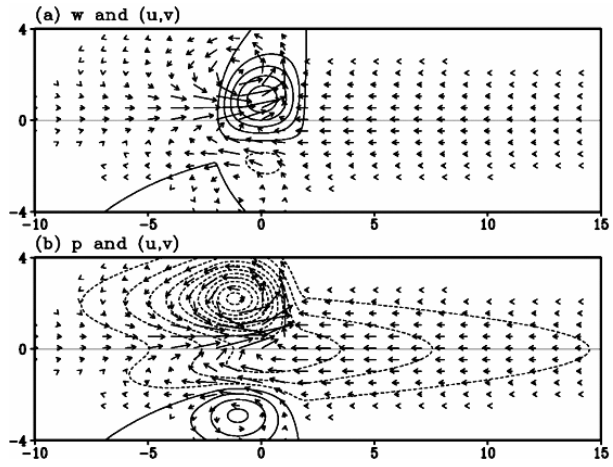
Figure 1. Gill’s solution for atmospheric response to a “monsoon- like heating” in an idealized equatorial plane of longitude and lati- tude (units: 1000km). (a) Upward motion (w, solid contours) is col- located with imposed heating at 0 longitude just north of the Equa- tor. Low-level zonal ( u ) and meridional ( v ) winds respond to im- posed heating, leading to convergence on the Equator and cyclonic circulations north of it, in a pattern that resembles the monsoons. (b) The response to the heating of surface pressure ( p , contours, dashed for negative values) is in approximate geostrophic balance with near-surface